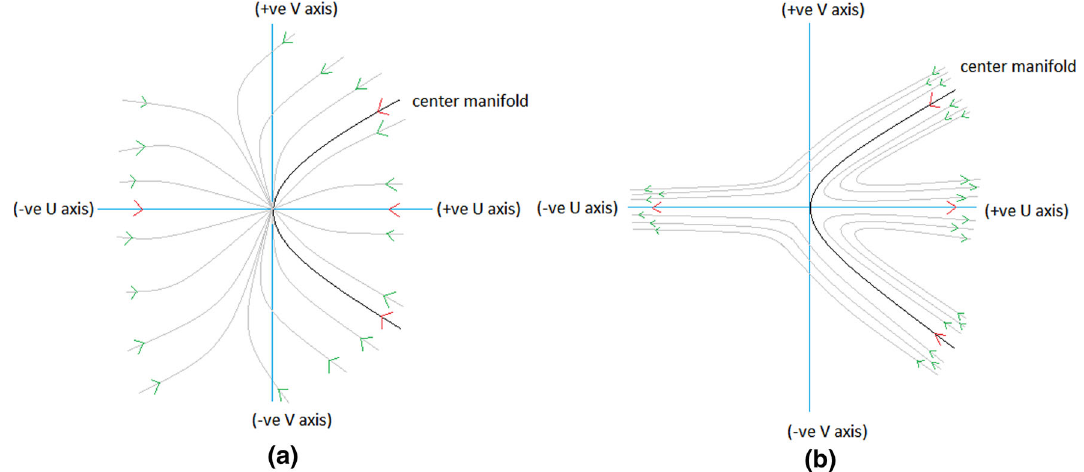
Fig. 12 Vector field near the origin in UV plane for the critical point P 5 . L.H.S. figure is for ( α < 3 ,μ < 0) and R.H.S. figure is for ( α > 3 ,μ < 0) Fig. 13 Phase potrait near the origin for the critical point P 6